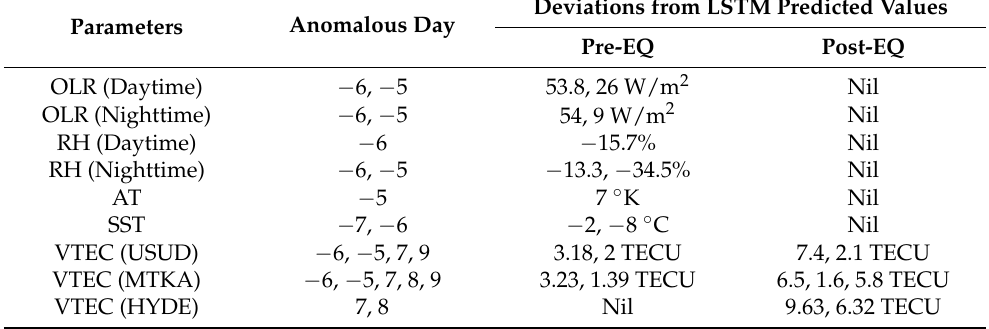
Table 3. Detected anomalies using LSTM